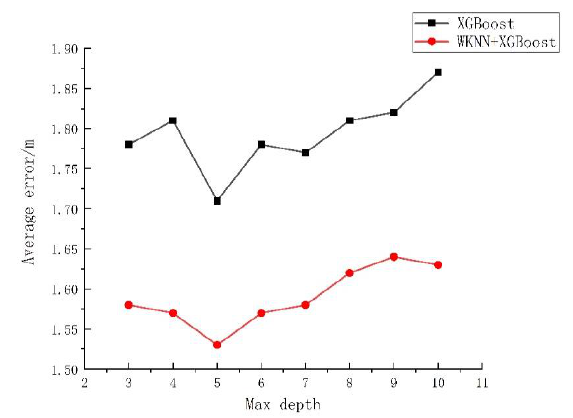
Figure 6. The influence of the depth of the trees on the error.